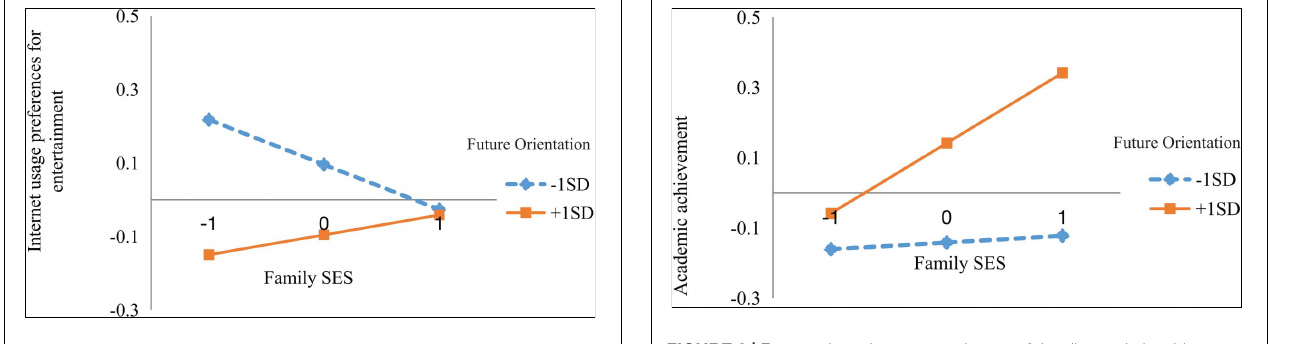
FIGURE 2 | Future orientation as a moderator of the direct relationship between SES and entertainment usage.